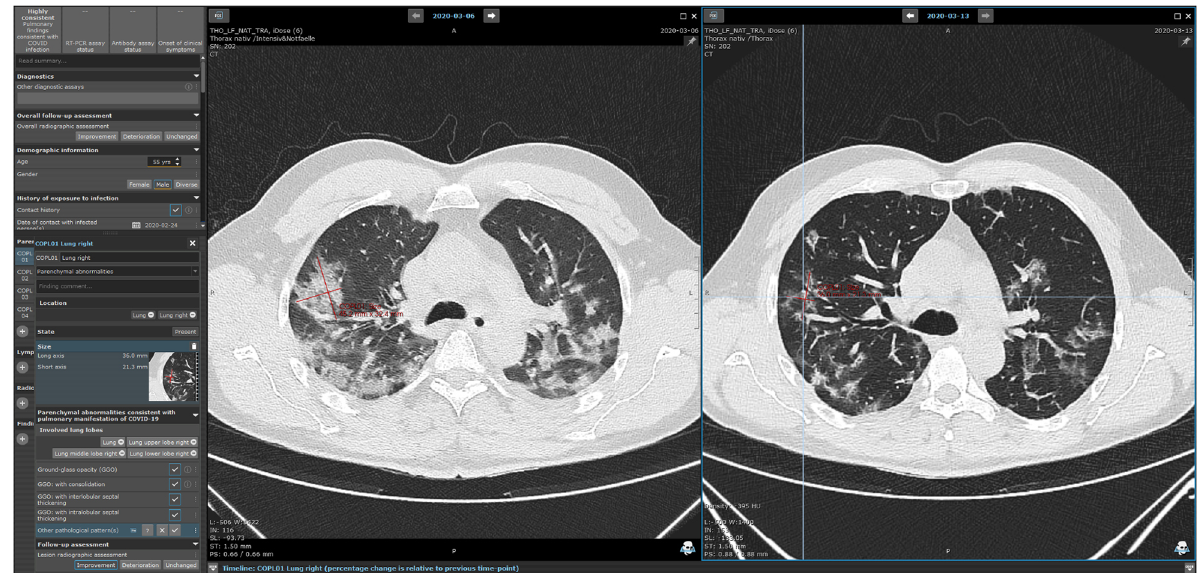
Fig. 1 COVID-19 EDC on the mint Lesion TM software platform. In this example, the patient had con fi rmed COVID-19 and underwent chest CT at two subsequent time points. The images were assessed and evaluated using the Mint EDC by an experienced radiologist. The assessment and evaluation are performed directly on primary imaging data supported by the automatic rule-based evaluation of disease progression. The patient was included in our feasibility clinical trial directly without the necessity for further data collection or redundant